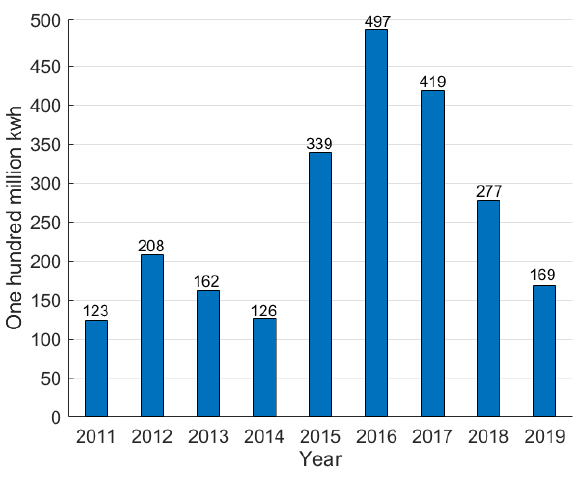
Figure 1. 2011 – 2019 national wind curtailment volume.